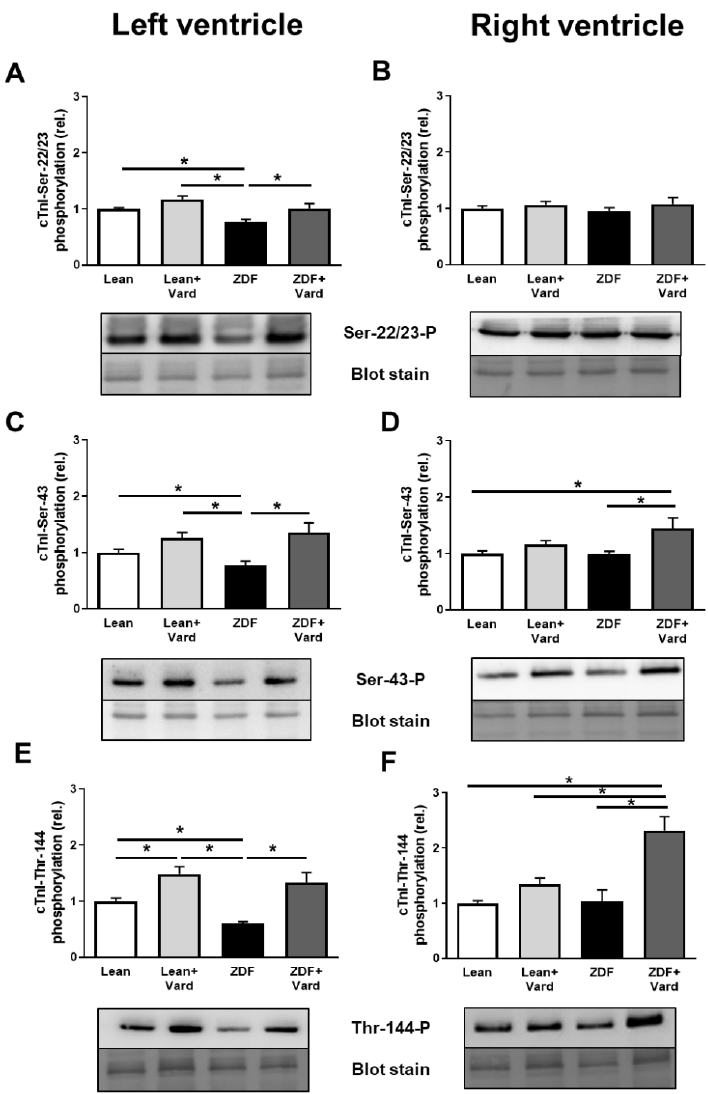
Figure 4. Results of site-specific phosphorylation assays for cTnI in the left ( A , C , E ) and right ventricles ( B , D , F ). Cardiac troponin-I (cTnI) phosphorylation levels at the Ser-22/23 ( A , B ), Ser-43 ( C , D ) and Thr-144 amino acid residues ( E , F ) were tested by Western immunoblotting in the Lean, Lean + Vard, ZDF, and ZDF + Vard groups for both ventricles. cTnI phosphorylation levels at Ser-22/23: LV Lean, 1.00 ± 0.02; LV Lean + Vard, 1.17 ± 0.06; LV ZDF, 0.77 ± 0.04; LV ZDF + Vard, 1.01 ± 0.09; RV Lean, 1.00 ± 0.05; RV Lean + Vard, 1.07 ± 0.06; RV ZDF, 0.95 ± 0.07; RV ZDF + Vard, 1.08 ± 0.11; at Ser-43: LV Lean, 1.00 ± 0.06; LV Lean + Vard, 1.26 ± 0.10; LV ZDF, 0.77 ± 0.08; LV ZDF + Vard, 1.35 ± 0.17; RV Lean, 1.00 ± 0.04; RV Lean + Vard, 1.16 ± 0.07; RV ZDF, 0.98 ± 0.05; RV ZDF + Vard, 1.45 ± 0.19; at Thr-144: LV Lean, 1.00 ± 0.06; LV Lean + Vard, 1.48 ± 0.13; LV ZDF, 0.61 ± 0.03; LV ZDF + Vard, 1.34 ± 0.17; RV Lean, 1.00 ± 0.05; RV Lean + Vard, 1.35 ± 0.12; RV ZDF, 1.04 ± 0.21; RV ZDF + Vard, 2.32 ± 0.25, all in relative units. Phosphorylation sites of cTnI were labelled with specific antibodies. Total protein amounts were assessed by a super sensitive blot stain. Bars represent means ± SEM (normalized to the mean of the Lean group as control), * p < 0.05, n = 9 – 15 independent determinations from at least four different hearts.